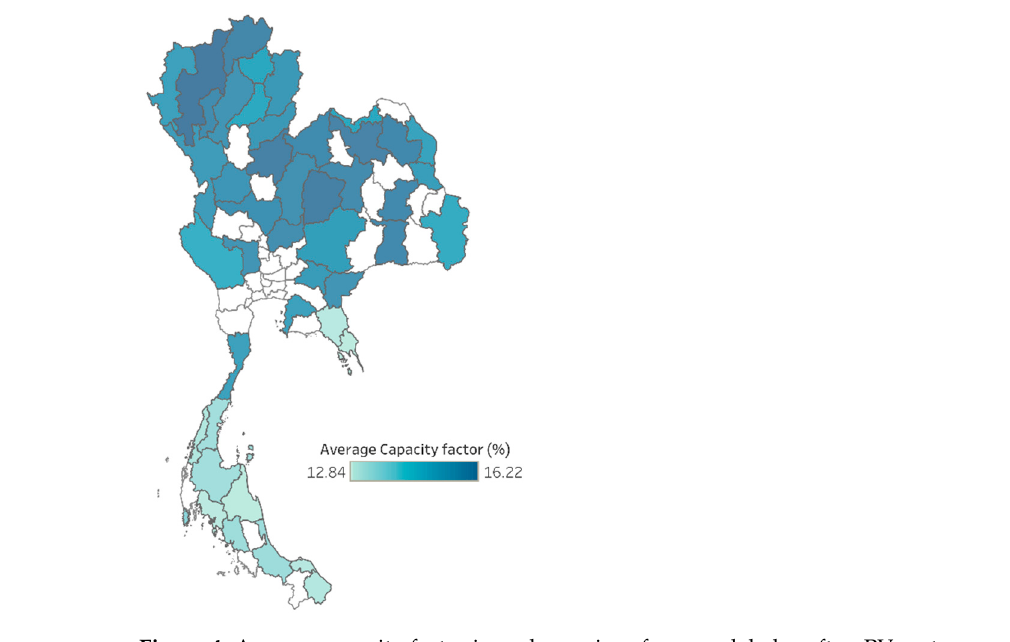
Figure 4. Average capacity factor in each province for a modeled rooftop PV system.